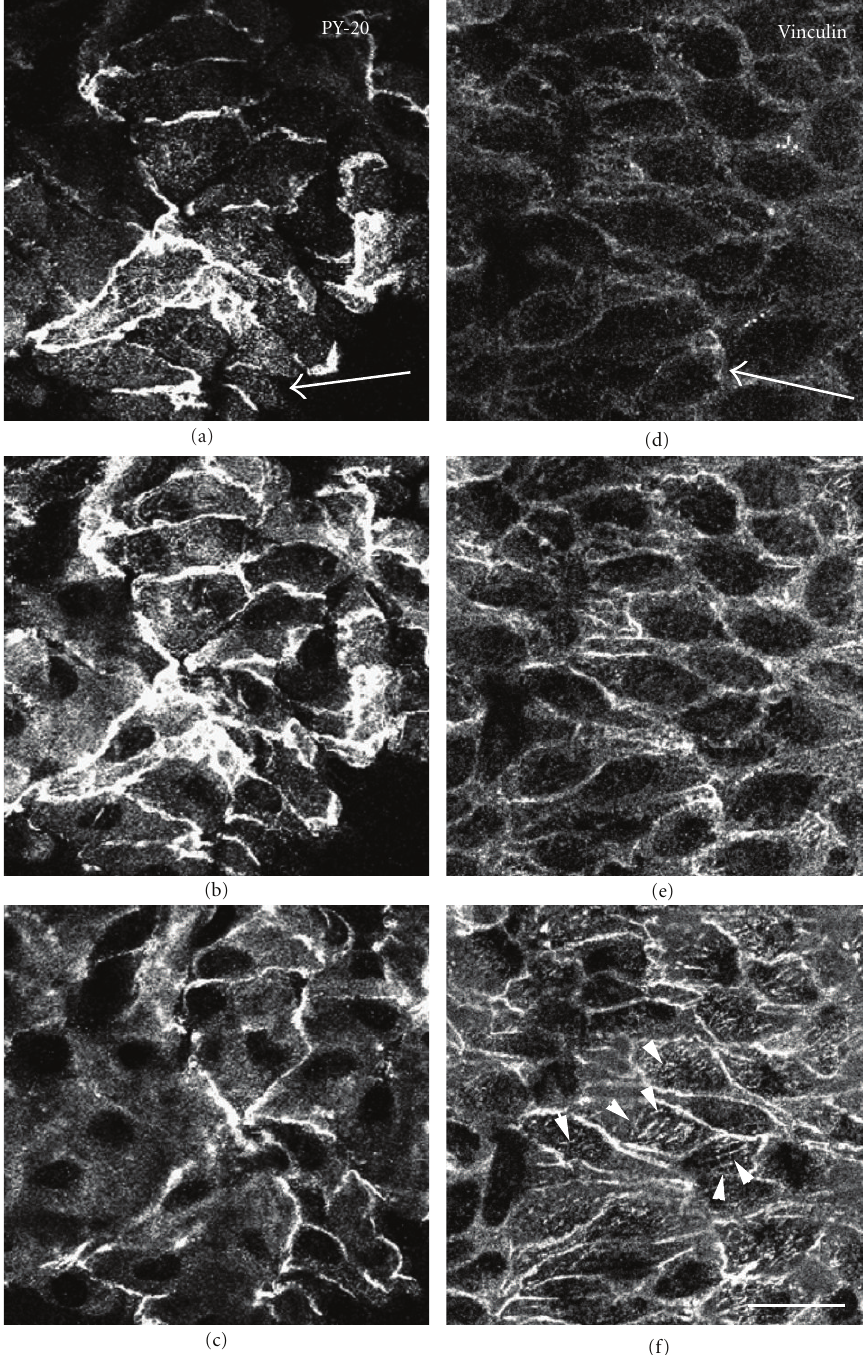
Figure 3: Localization of tyrosine-phosphorylated proteins and vinculin in the renal arterial endothelial cells. En face preparations were stained with antiphosphotyrosine antibody (PY-20) (a–c) or antivinculin antibody (d–f) and observed by confocal laser scanning microscopy. The focal plane was adjusted to the surface (a and d), middle (b and e), or basal (c and f) portion of the endothelial cells. Tyrosine-phosphorylated proteins were observed along the apical plasma membrane in uniform staining (a). Strong staining for tyrosine- phosphorylated proteins was detected at sites of cell-to-cell apposition (b), with faint staining in the cytoplasm (c). Antivinculin staining was detected at sites of cell-to-cell apposition (e) and focal adhesion in the basal portion of the cells (f: arrowheads). No staining for vinculin was detected at the apical surface of the cells (d). The arrow indicates the direction of blood flow. Bar: 50 µ